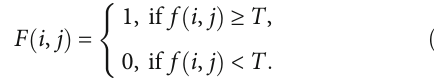
Figure 4: Particle bonding network ([34]). The red and blue lines in the fi gure represent the shear stress and normal stress between particles, respectively. The thickness of the line represents the value of the force.